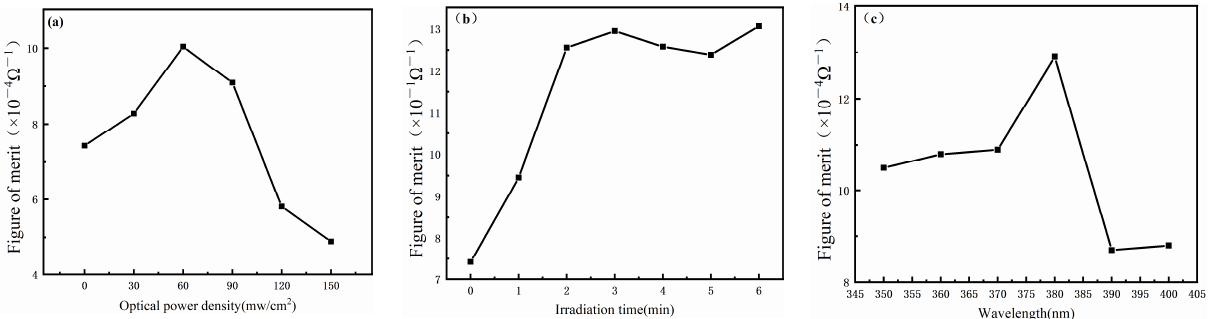
Figure 4. Figure of merit diagram showing the influence of different factors on UV welding. ( a ) Optical power density ( b ) Irradiation time ( c ) Ultraviolet wavelength. cal power density ( b ) Irradiation time ( c ) Ultraviolet